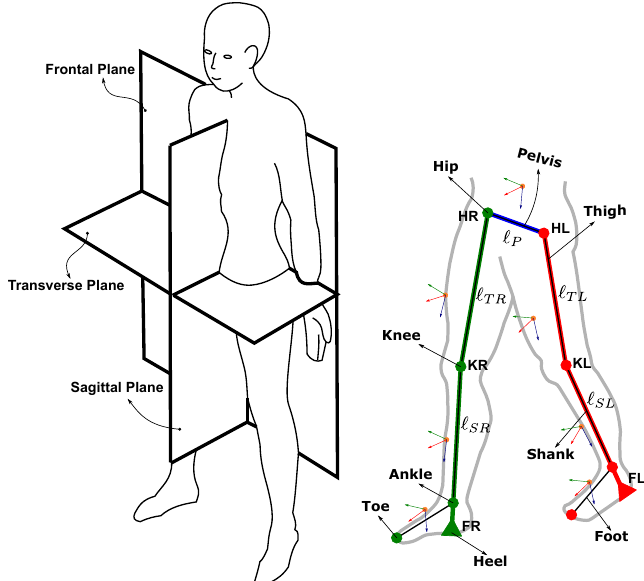
Figure 3. Human body coordinates and lower limb segments. ( left ) The human body can be divided into three orthogonal planes. ( right ) Skeletal model for lower limb segments and wearable sensor locations after Vaughan et al.